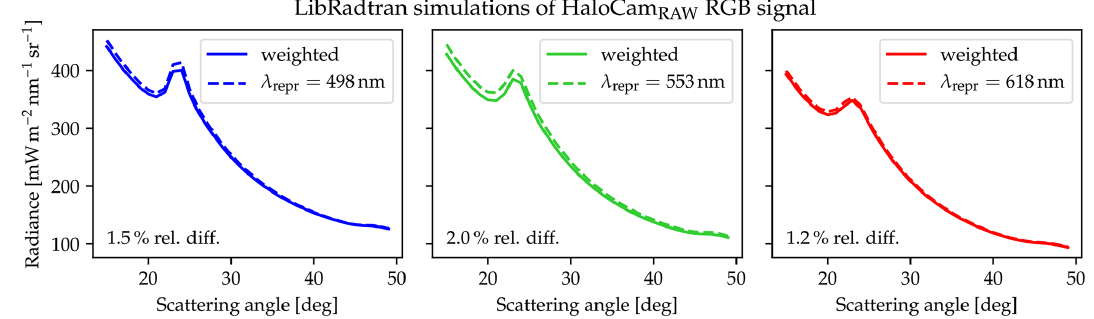
Figure B3. Radiative transfer simulations performed with libRadtran for the HaloCam RAW red, green, and blue channels in the principal plane above the Sun with SZA = 45 ◦ . A cirrus cloud with COT = 1 (at a wavelength 550nm), r eff = 20µm, and a mixture of 25% smooth and 75% severely roughened solid columns was assumed. The continental average aerosol mixture from OPAC was chosen with AOT = 0 . 1 at 550nm.